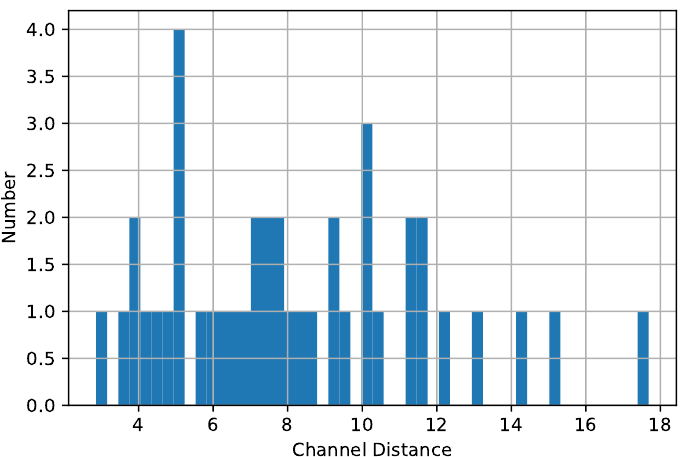
Figure 10. The histogram of Euclidean distances between AVs and MAV of class 0 of training images.